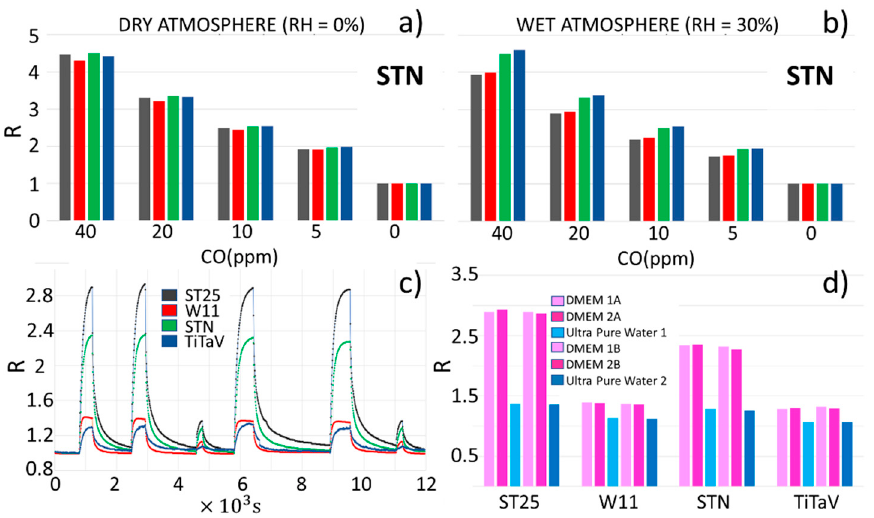
Figure 4. Sensor reproducibility and measure repeatability. ( a ) Response amplitudes ( 𝑅 ) of four different STN sensors exposed to decreasing CO concentrations (from 40 to 0 ppm) in dry atmosphere. ( b ) Same as ( a ), but in 30% relative humidity; ( c ) plot of 𝑅 vs. time of the sensors equipping the SCENT B1 (ST25, STN, TiTaV, and W11), exposed repetitively to different batches of DMEM and pure water to assess the measures’ repeatability; ( d ) bar graph of 𝑅 for each sensor to the samples of ( c ).